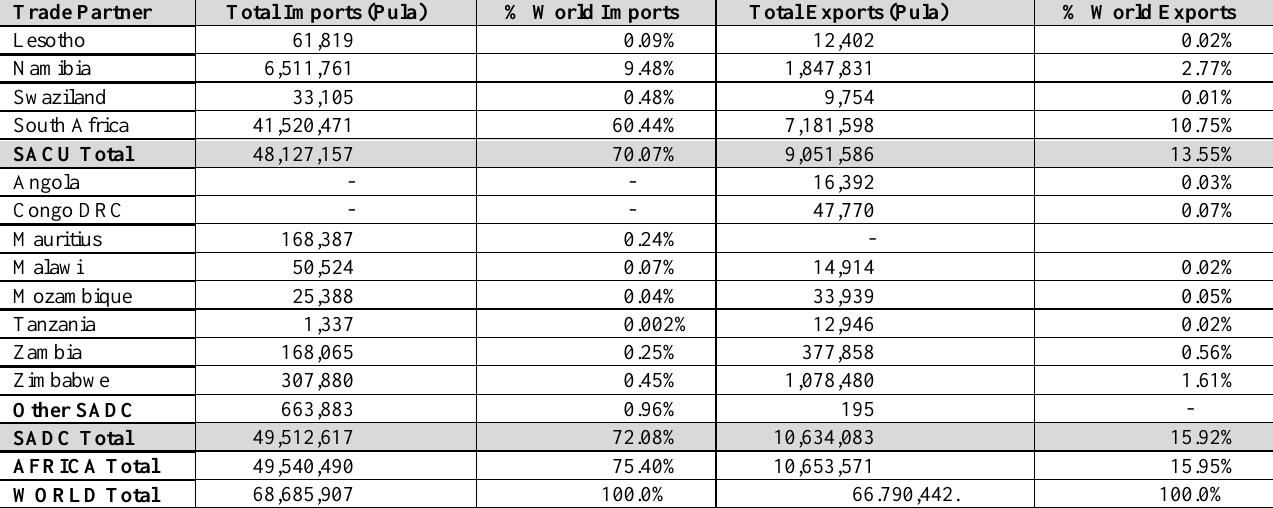
Table 1: Botswana exports and imports with SACU and SADC Regions 2013 Trade